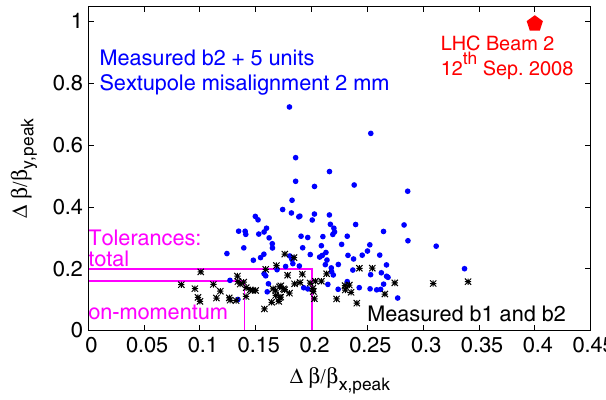
FIG. 5. (Color) Simulations (black and blue), observation (red), and tolerances (magenta) of the peak beta beating in the LHC, showing an unexpectedly large measured beta beating for beam 2.